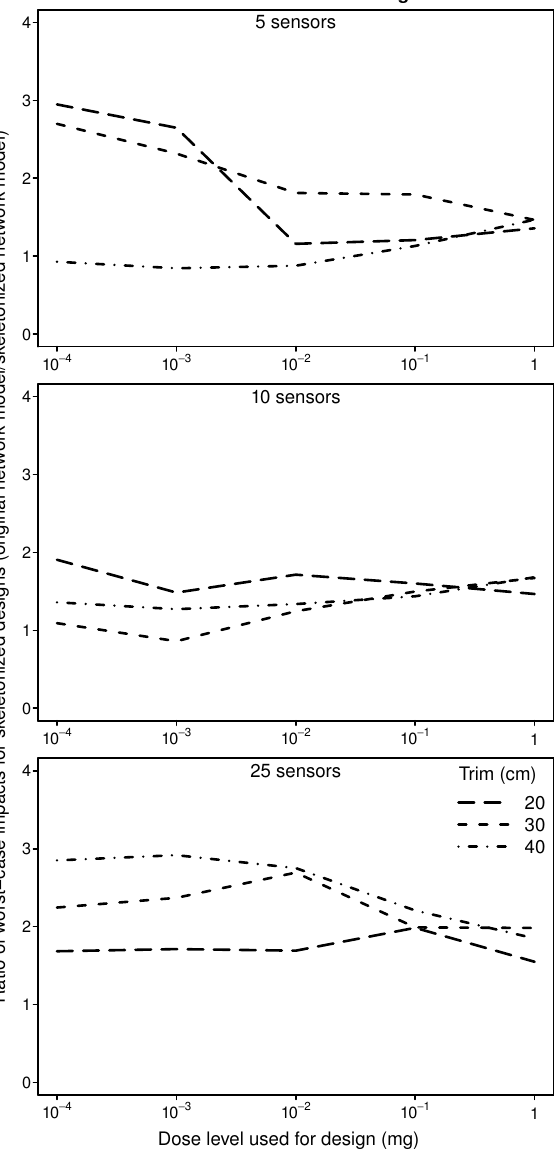
Figure 3. Relative worst-case impacts for transplanted and non- transplanted worst-case CWS designs for Network N1. Results are shown for three levels of network skeletonization (trims).